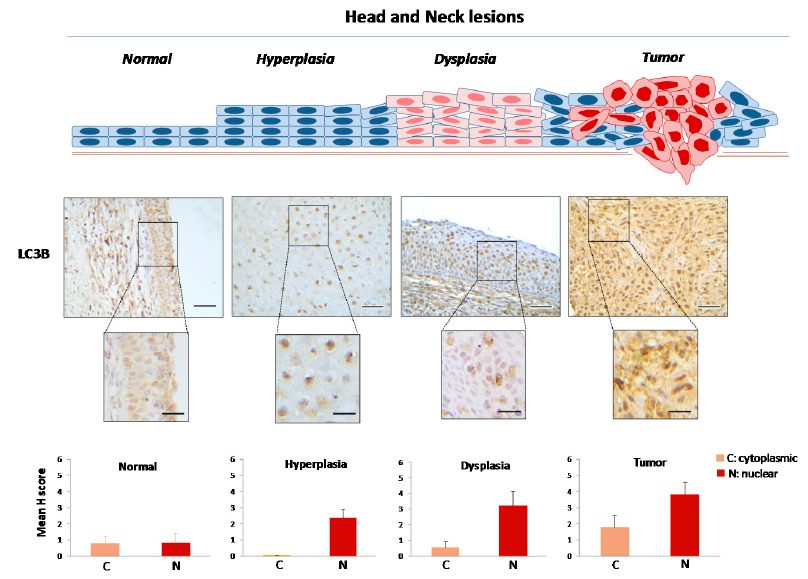
Figure 5. Immunohistochemical expression patterns of LC3B in head and neck lesions. Representative images of cytoplasmic and nuclear immunohistochemical localization of LC3B in normal laryngeal epithelium, hyperplastic and dysplastic lesions, as well as in tumor areas from the same patient. Bars in the histograms denote the cytoplasmic and nuclear mHscores of LC3B in each stage (± SE: standard error). The cytoplasmic mHscores refer to the punctate localization pattern of LC3B (see also Figure S1) representing the LC3B-II lapidated form that participates in the autophagosome formation. Scale bars: 100 μ m; scale bars of insets: 50 μ m.